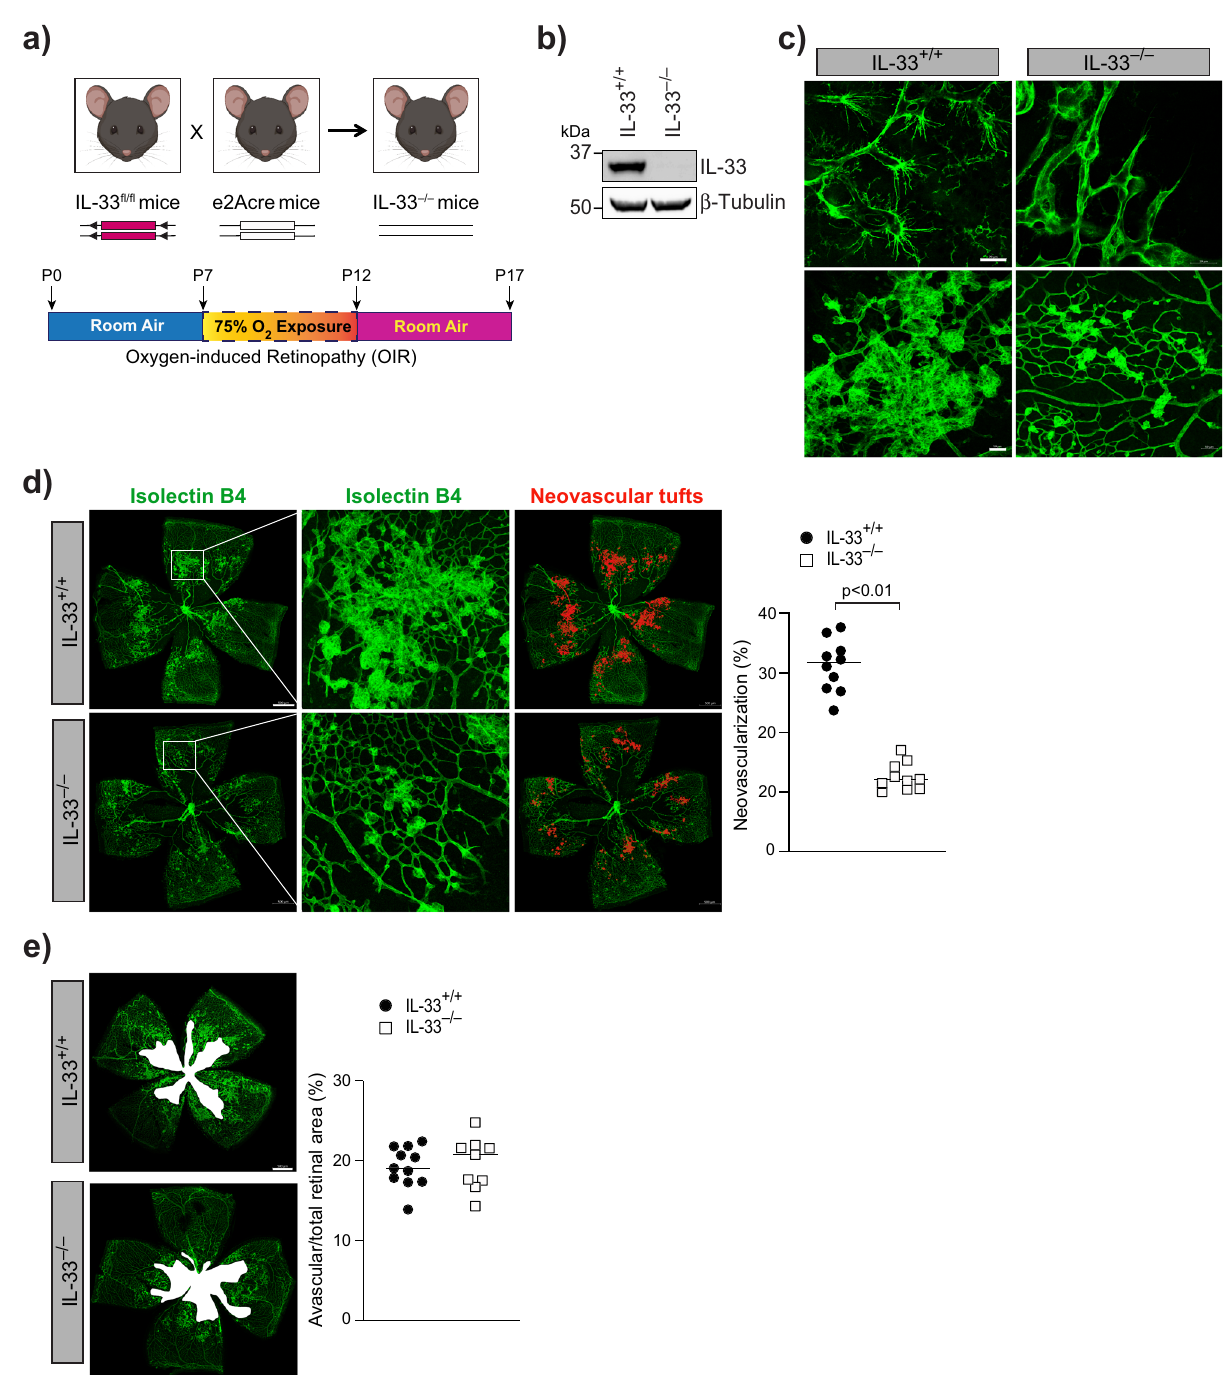
Fig. 3 Genetic knockdown of IL-33 reduces OIR-induced retinal neovascularization. a Schematic diagram of breeding strategy for the generation of IL-33 knockout mice. b Eyes from IL-33 + / + and IL-33 − / − pups were enucleated, retinas isolated, and extracts were analyzed for IL-33 levels by Western blotting and normalized to β -tubulin. c – e Everything is same as in b , except that retina from IL-33 + / + and IL-33 − / − mice pups were stained with isolectin B4, and fl at mounts were prepared and examined for endothelial tip cell formation ( c ) retinal neovascularization ( d ), and avascular area ( e ). The middle column in d shows the higher magni fi cation of the area selected. Neovascularization is highlighted in red in the third column of d . The bar graphs represent quantitative analysis of percentage of neovascularization and avascular area, expressed as Mean ± SD. * P < 0.05 vs control siRNA. Scale bar represents 20 μ m in c upper row, 50 μ m in c lower row, 500 μ m in d and e the angiogenic effects of IL-33 in retinal ECs are independent of VEGF-A-VEGFR2 signaling.